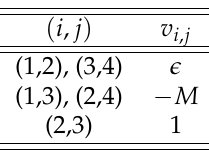
Figure 3. Graph G and valuations v i , j .